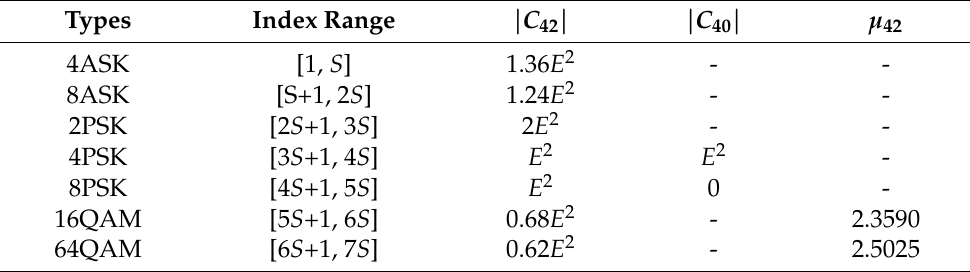
Table 1. Index range and theoretical values of features of different modulation